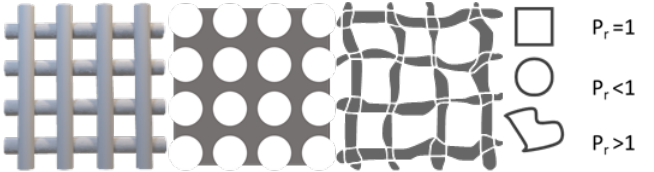
L = perimeter, A = area.